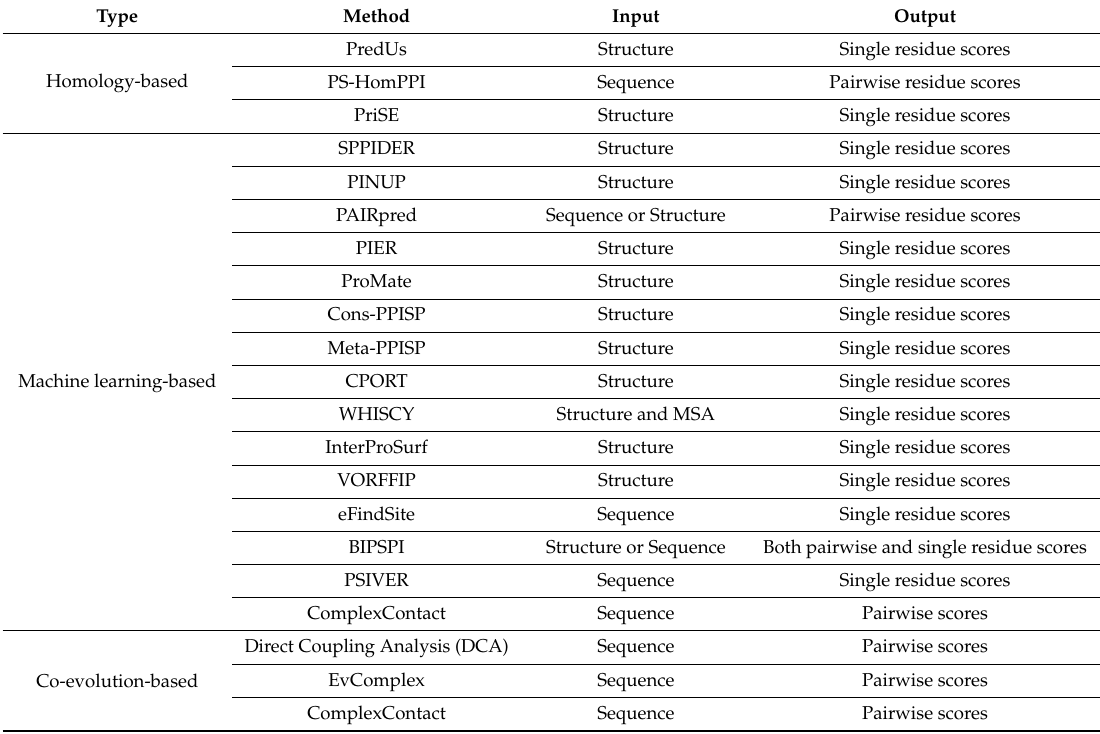
Table 1. List of known methods for predicting Protein-Protein Interaction Interfaces